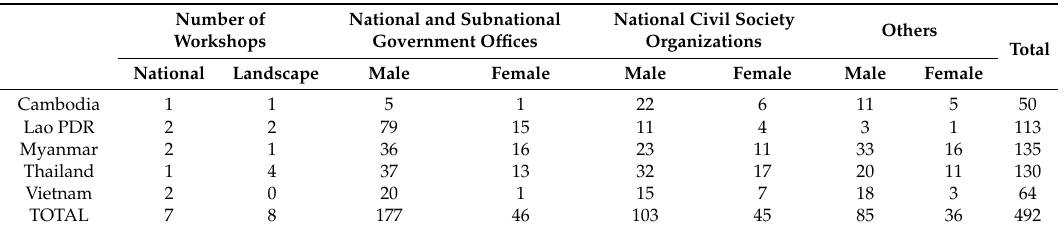
Table A2. Participants in national and landscape quantitative (EEAT) and qualitative (situational analysis) data collection workshops in each GMS